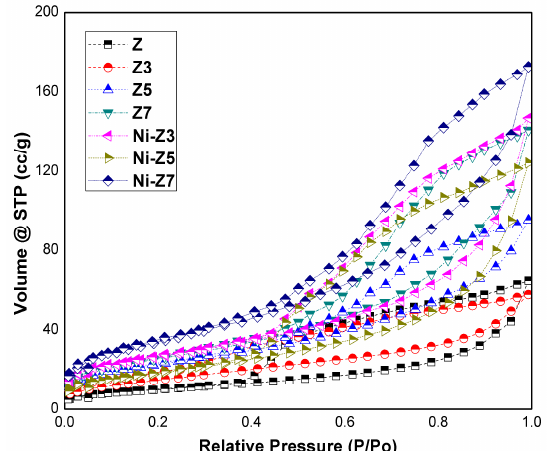
Figure 5. N 2 gas adsorption–desorption isotherm comparison graph of Z, Z3, Z5, Z7, Ni-Z3, Ni-Z5, and Ni-Z7.